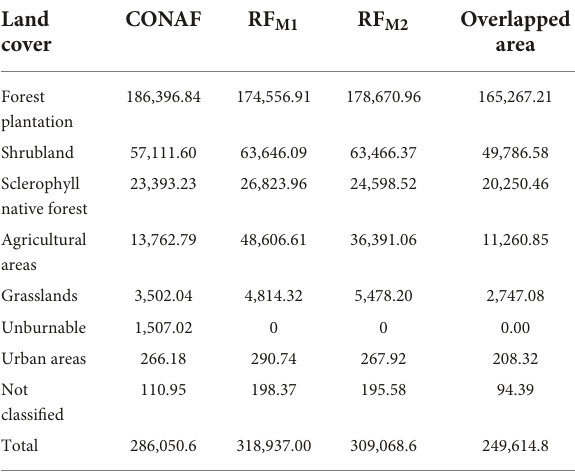
TABLE 3 Distribution of burned area in hectares by type of land cover in each of the classifications of the burned area obtained and in the official delimitation the category “overlapped” includes the burned area that coincides in the three classifications (RF M1 , RF M2 , and